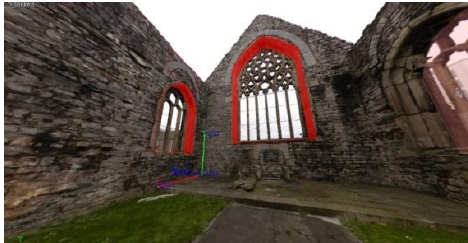
Figure 8 Modelling of windows of the ruin in ImageModeler.